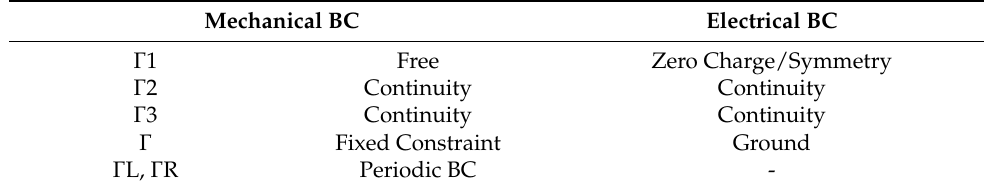
Table 2. Boundary conditions (BC).